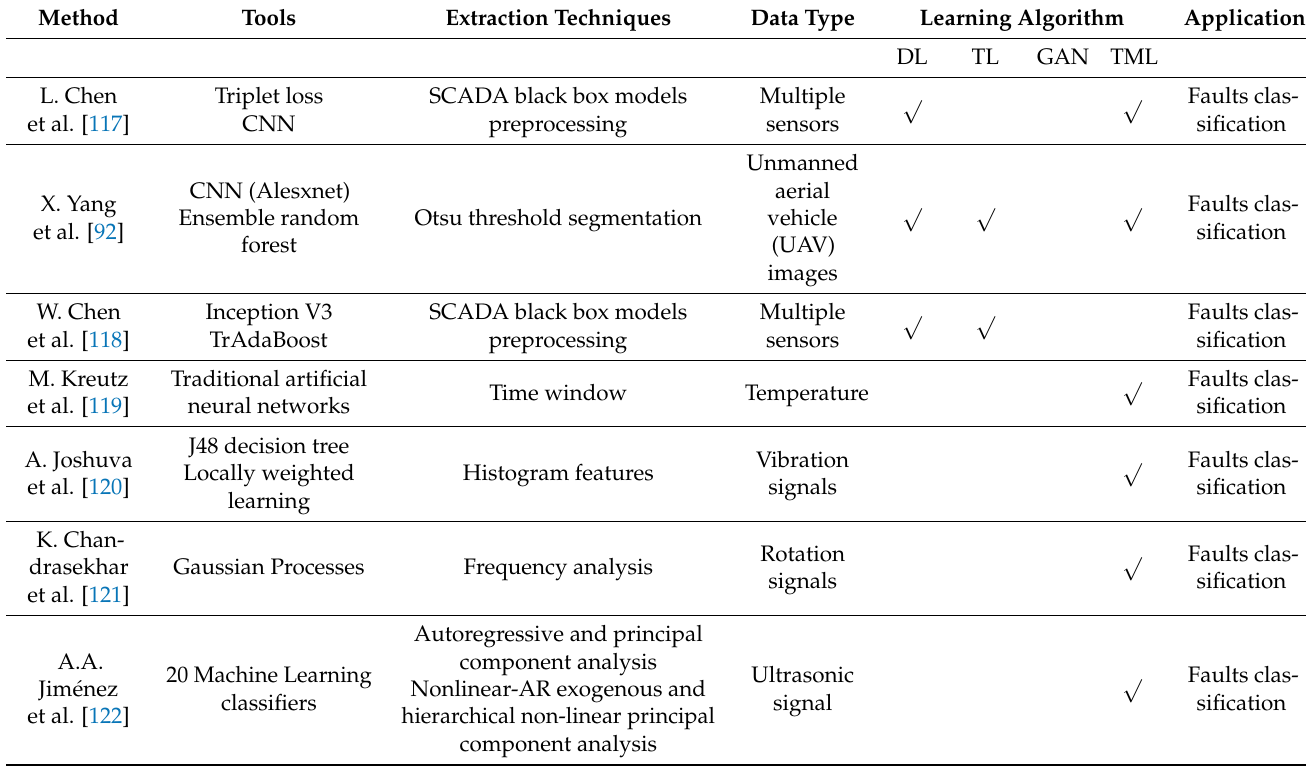
Table 4. Blade condition monitoring state of the art